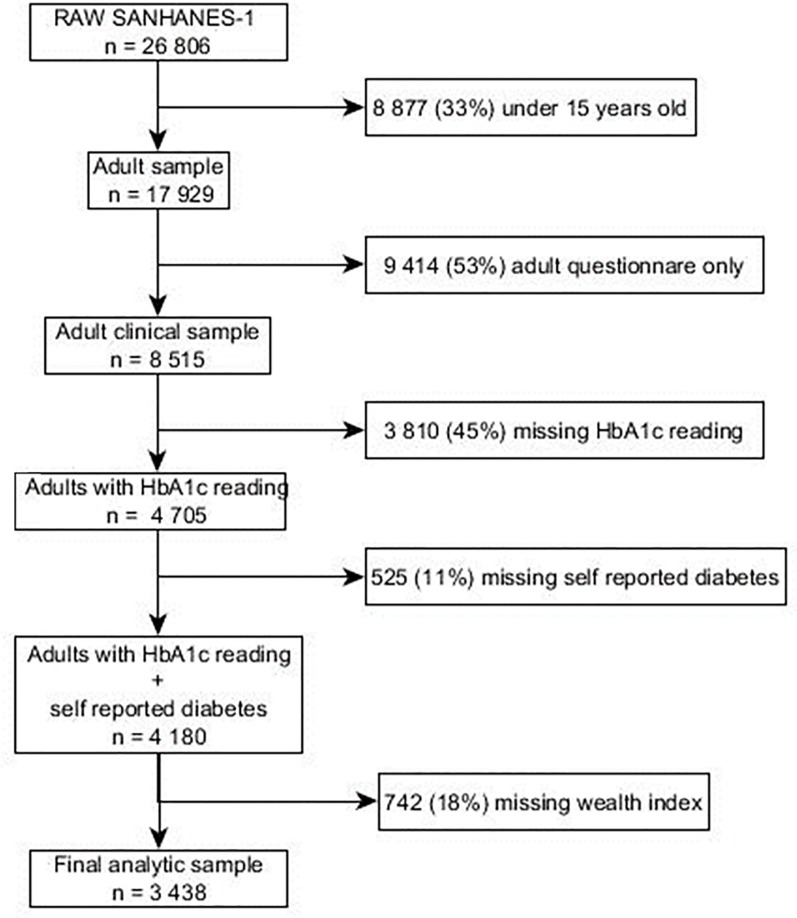
Flow chart for selecting the analytical sample from the general survey sample.